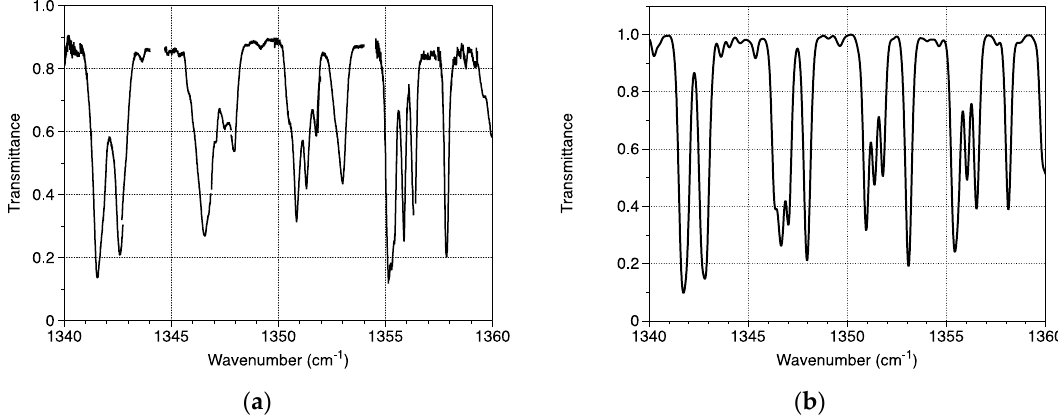
Figure 5. ( a ) Transmission spectra of the DFB QCL array through the methane gas cell and ( b ) transmittance calculated from HITRAN data in the same conditions than the experience.